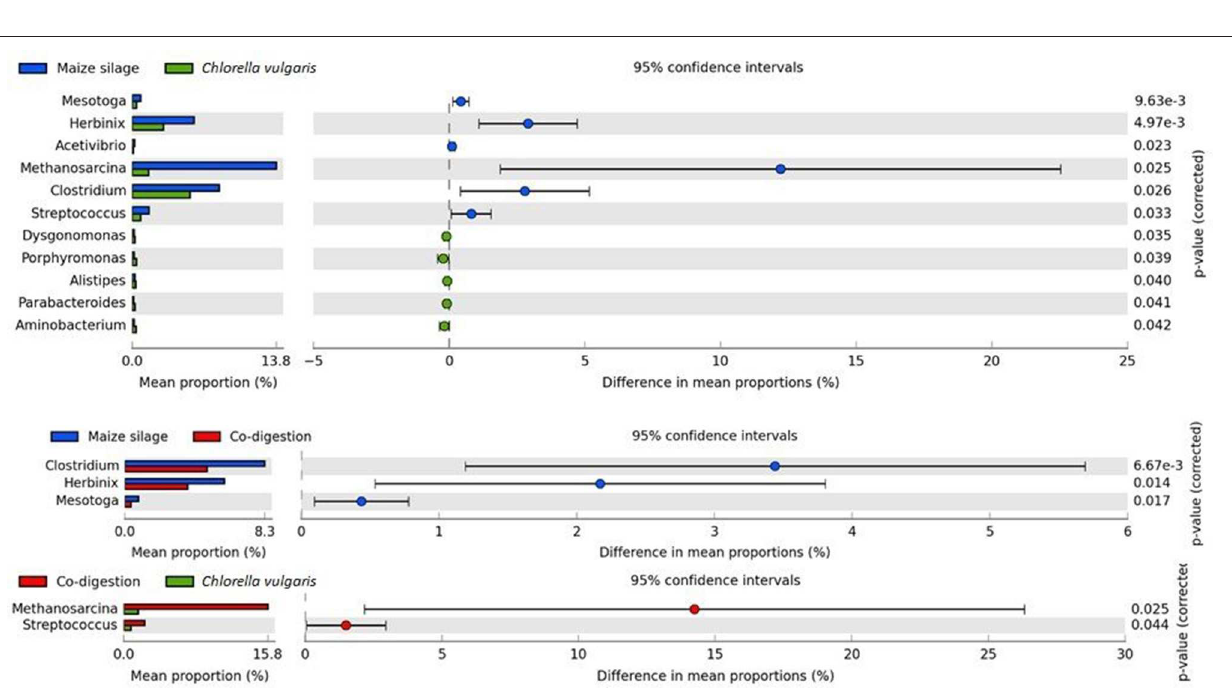
Frontiers in Energy Research | www.frontiersin.org